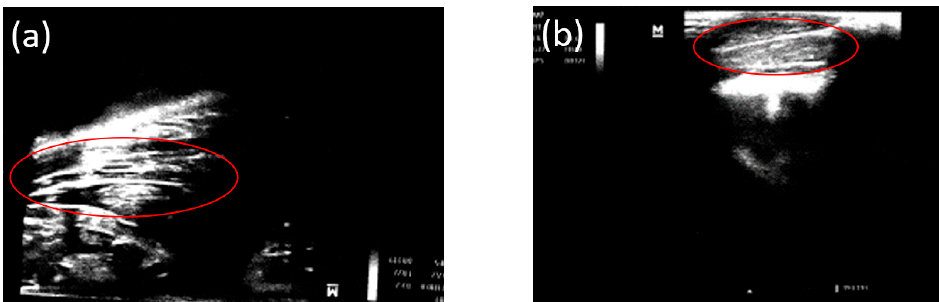
Figure 6. Ultrasound data of the postoperative area after ( a ) 3 months and ( b ) 6 months. The gas layer in the soft tissues was visualized.